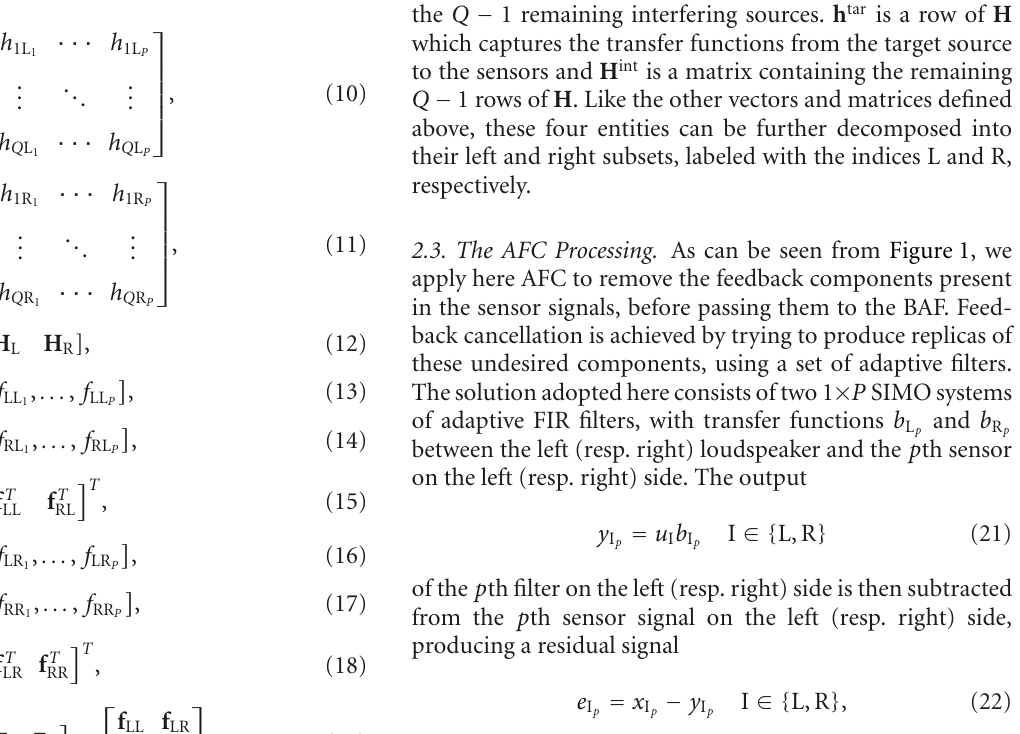
Figure 1: Signal model of the AFC-BAF combination.